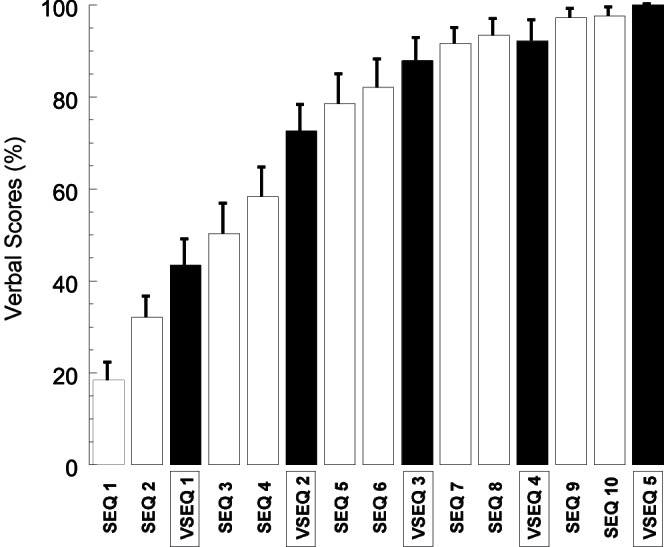
Behavioral results.Mean Verbal Score (±SE) are plotted in percentage per each SEQ (white columns) and VSEQ (black columns) block.